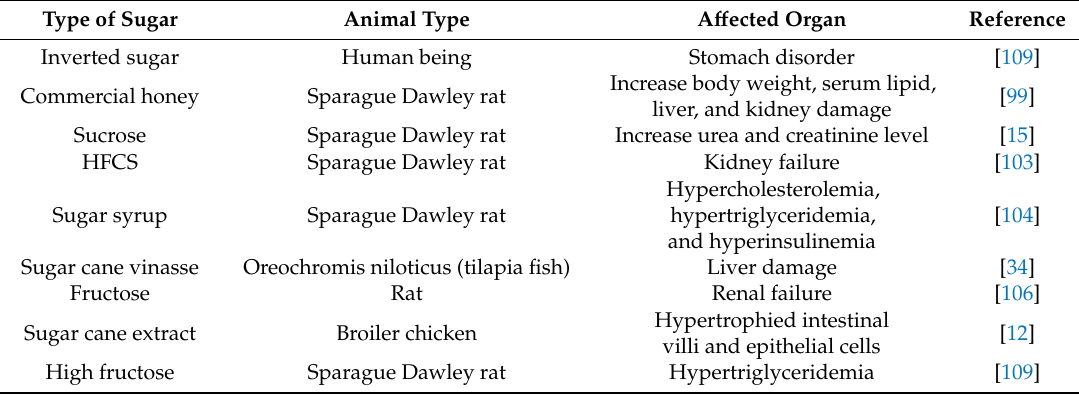
Table 5. Di ff erent in vivo studies of sugar adulterant impact on an internal